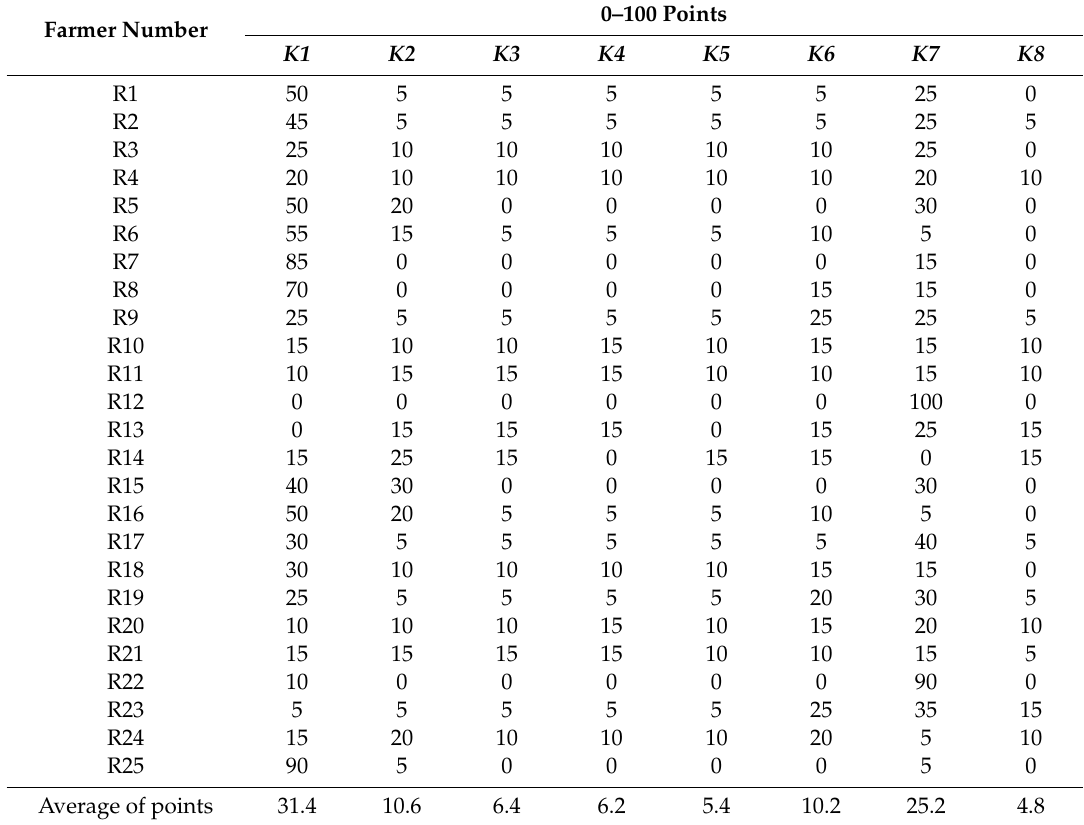
Table 1. Evaluation of the importance of the adopted